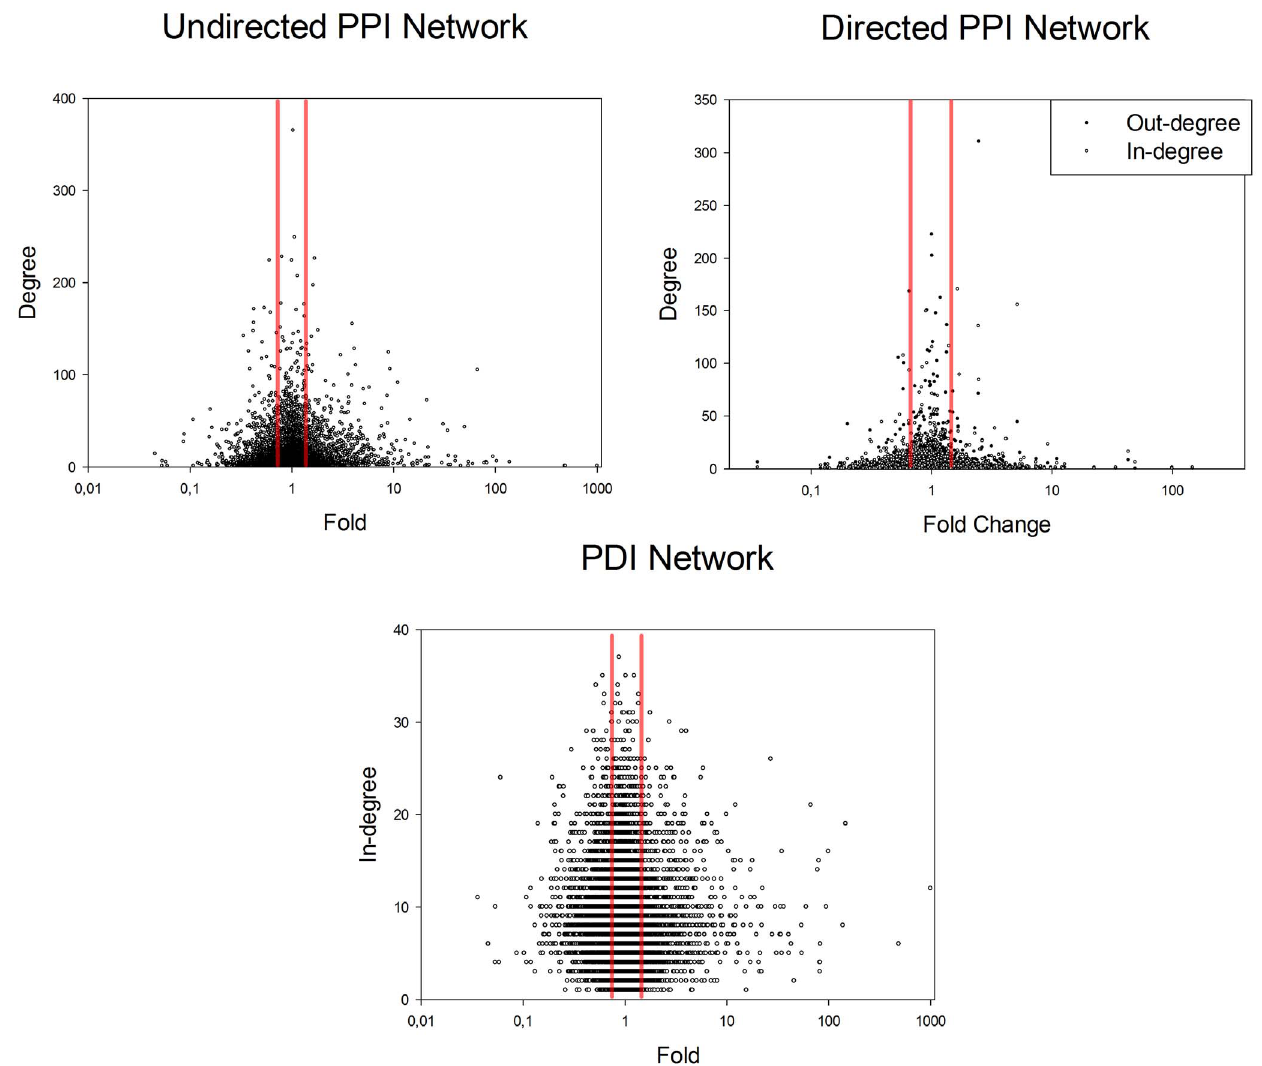
Figure 2. Degree-Fold Change relationship. Nodes with higher degree has lower fold change of gene expression in all network types. Genes between red lines have higher average degree and are filtered out from network analysis. Remaining nodes in DEG-derived networks have lower average degree and connectivity.